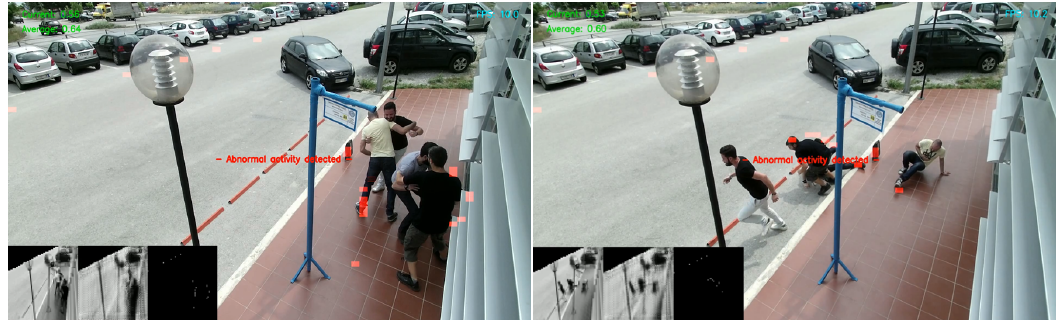
Figure 23. Experimental outdoor evaluation with a fighting scenario on a simulated bus stop. Red regions represent abnormalities in the frame.